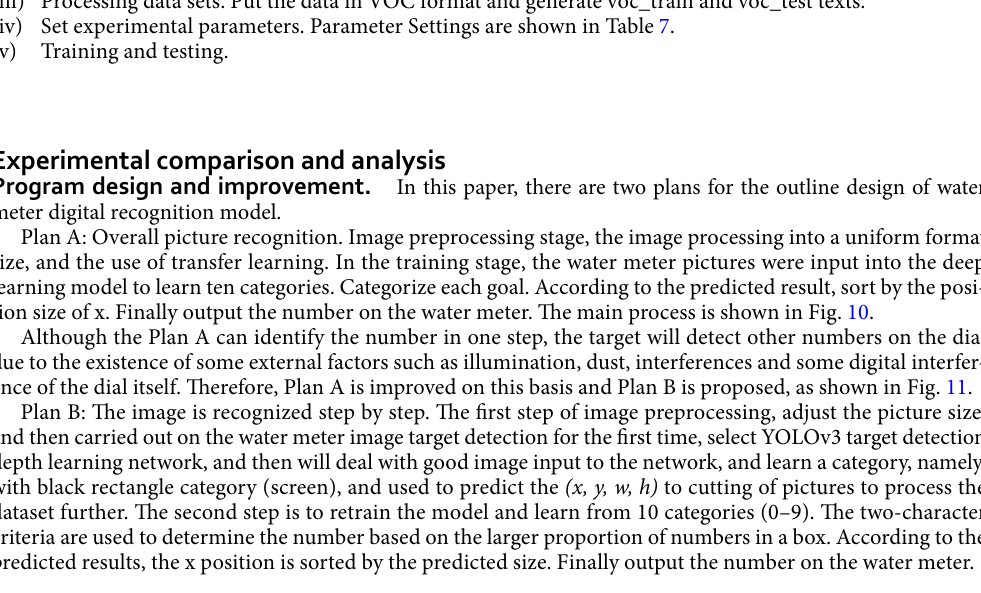
Figure 12. Display of detection images of some water meters with black bounding